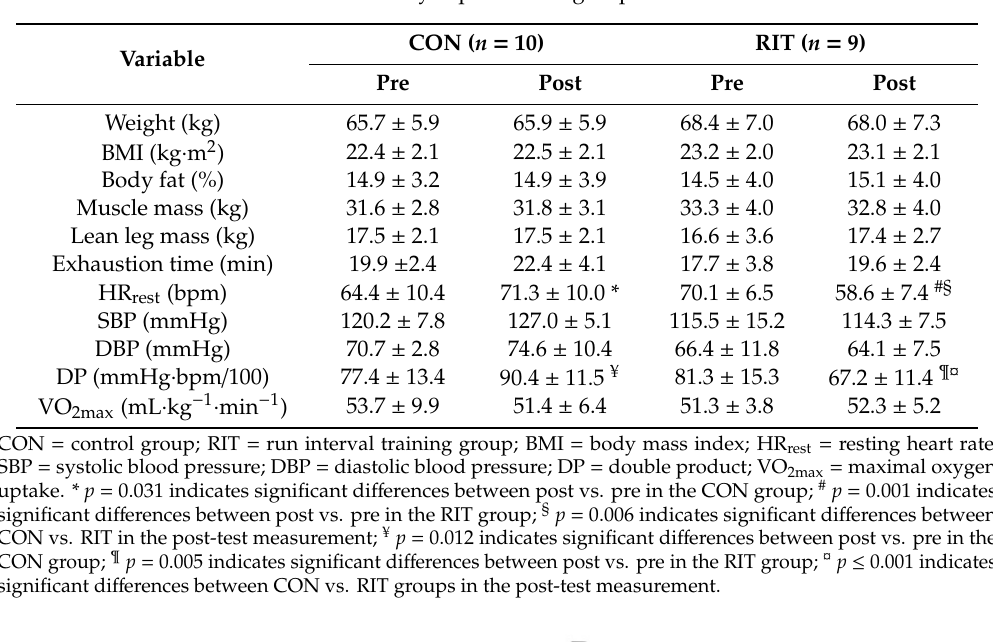
significant di ff erences between CON vs. RIT groups in the post-test measurement.